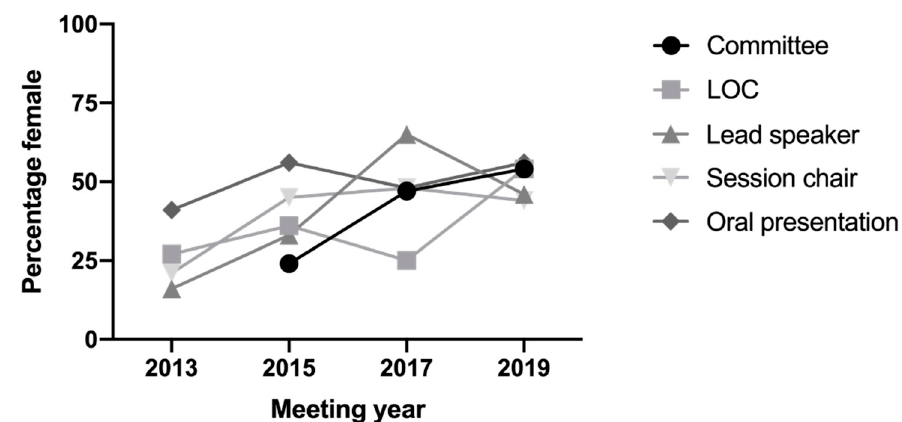
Figure 2. Gender composition within the Australasian Virology Society. Committee, AVS management committee; LOC, local organising committee; lead speaker includes both national and international invited speakers; oral presentation, speakers selected from abstract.